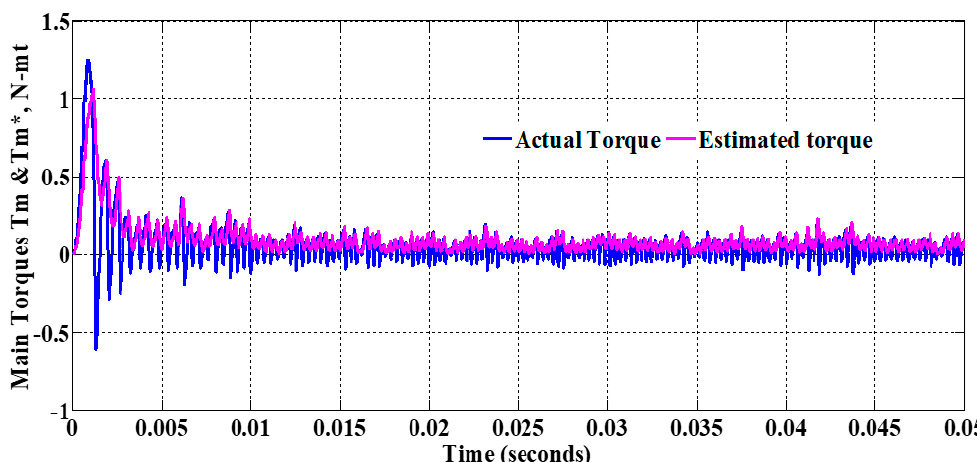
Figure 15. Estimated and actual net torques.